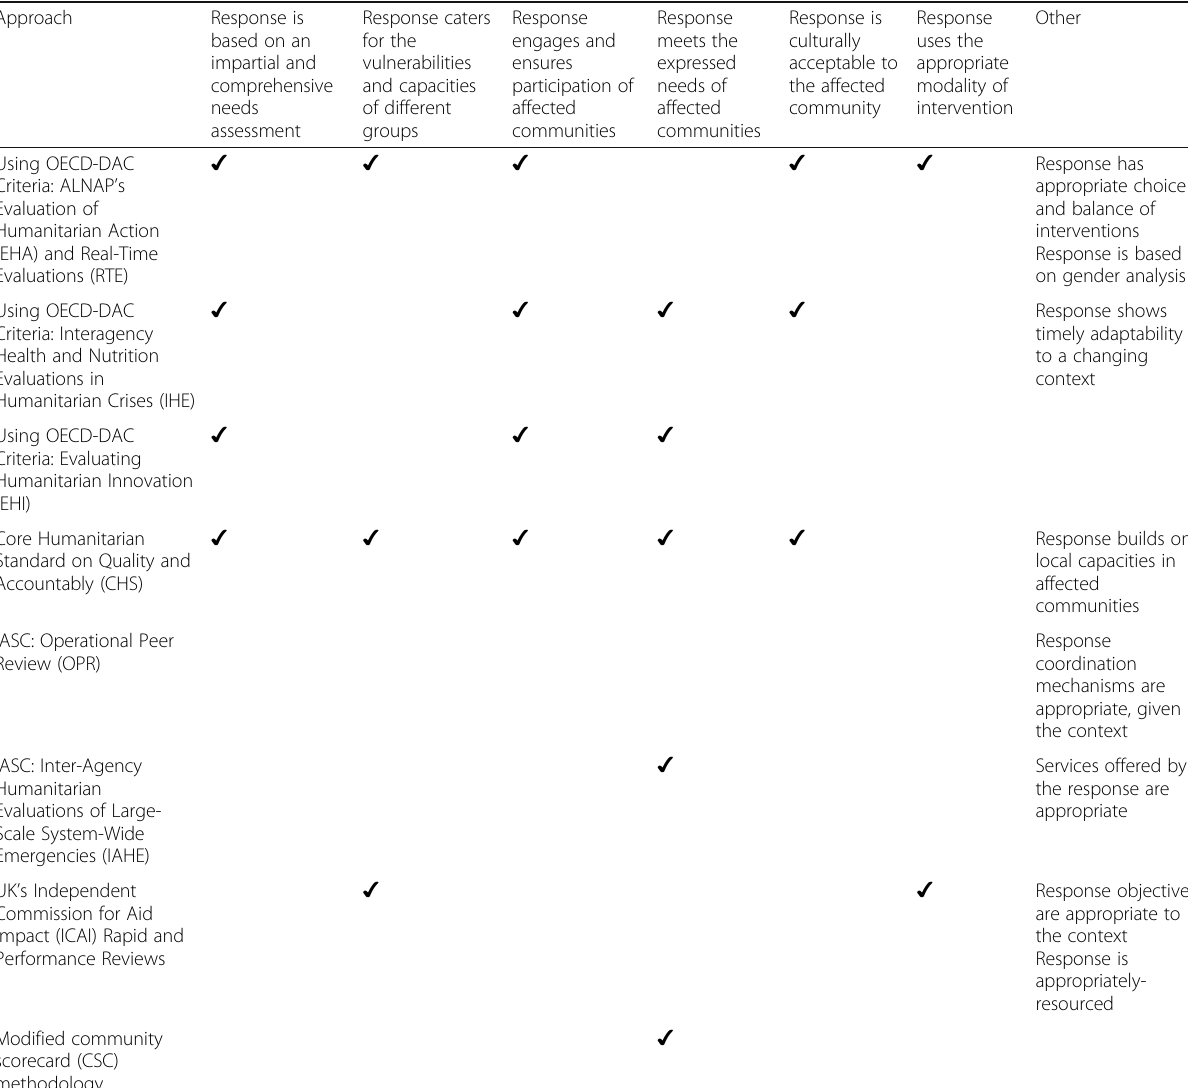
Table 2 Aspects of ‘ appropriateness ’ considered by different evaluation approaches